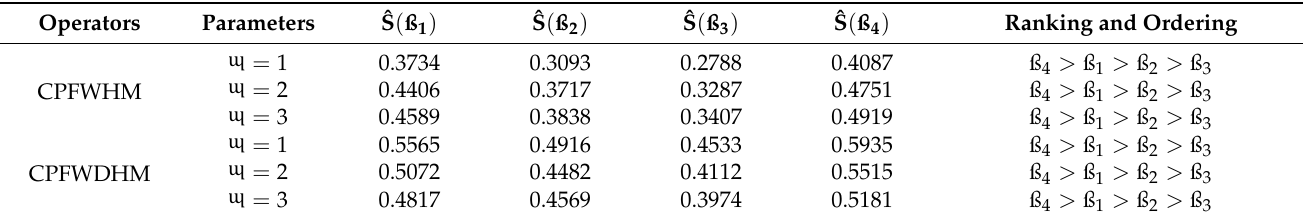
Table 5. Ranking and ordering of the consequences of CPFWHM and CPFWDHM